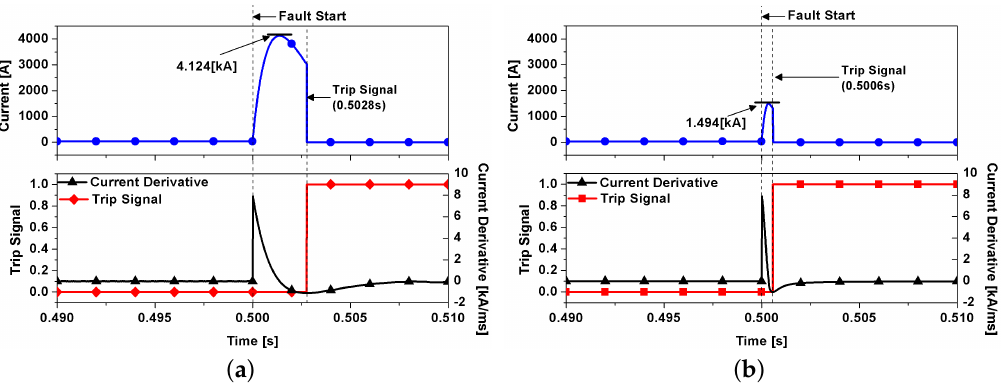
Figure 8. Fault Current and Trip Signal in Selective Protection Relay ( a ) W/O SFCL ( b ) With